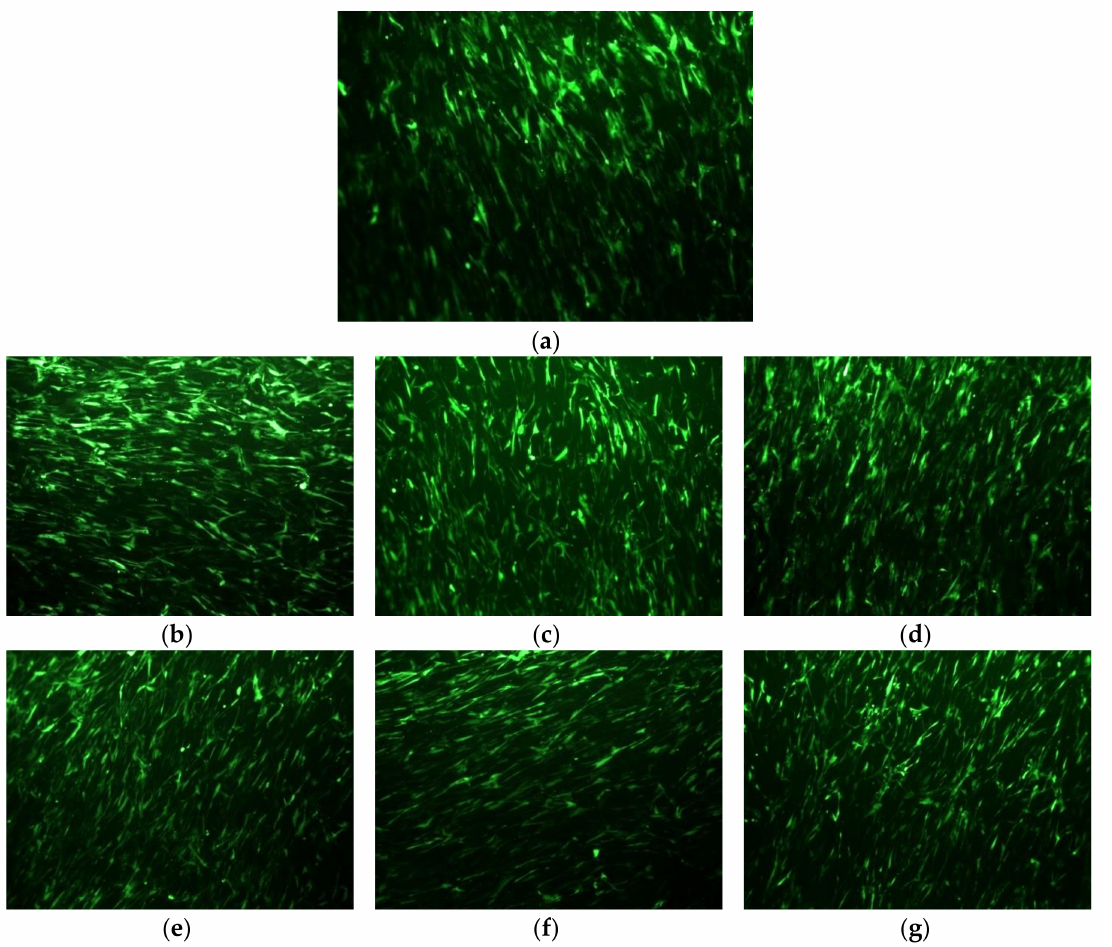
Figure 14. Genetically modified WJ-SCs on ( a ) PCL, ( b ) PCL/bBG 0.5%, ( c ) PCL/bBG 1%, ( d ) PCL/bBG 2.5%, ( e ) PCL/tBG 0.5%, ( f ) PCL/tBG 1.0% and ( g ) PCL/tBG